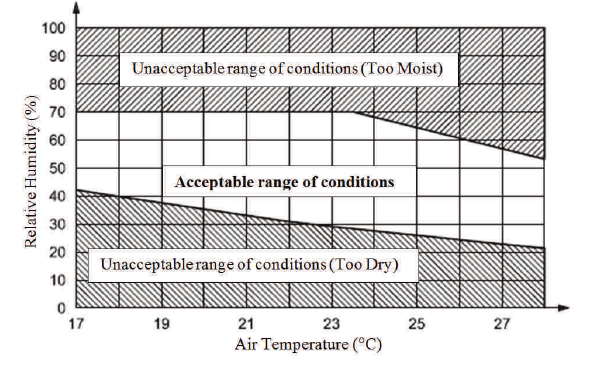
Fig. 3. Laboratory Air Conditions [10, 11]